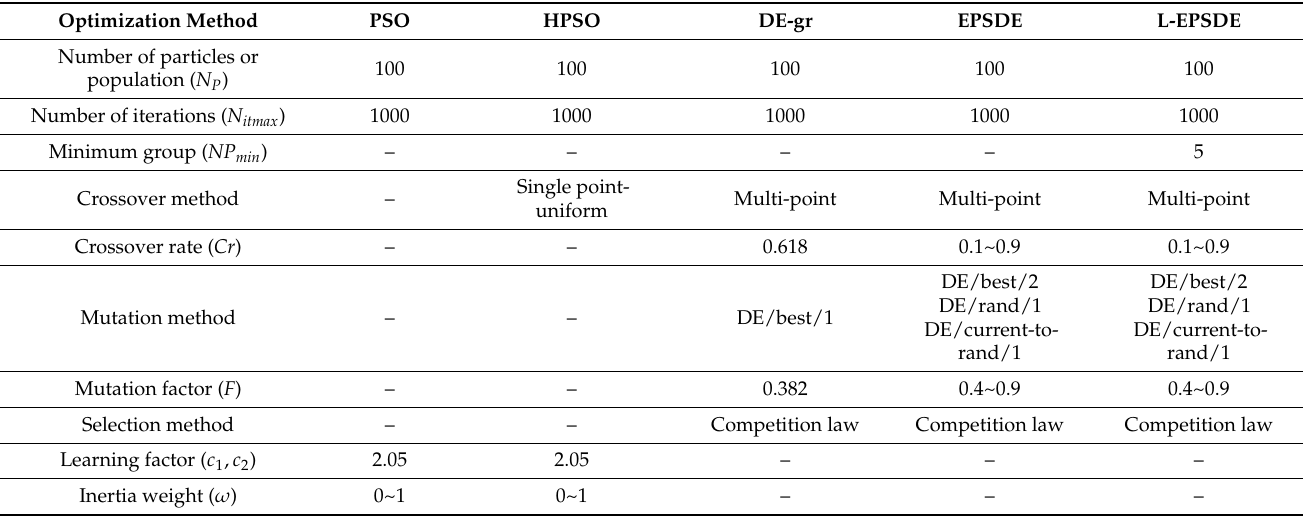
Table 1. Parameters of five optimization methods.